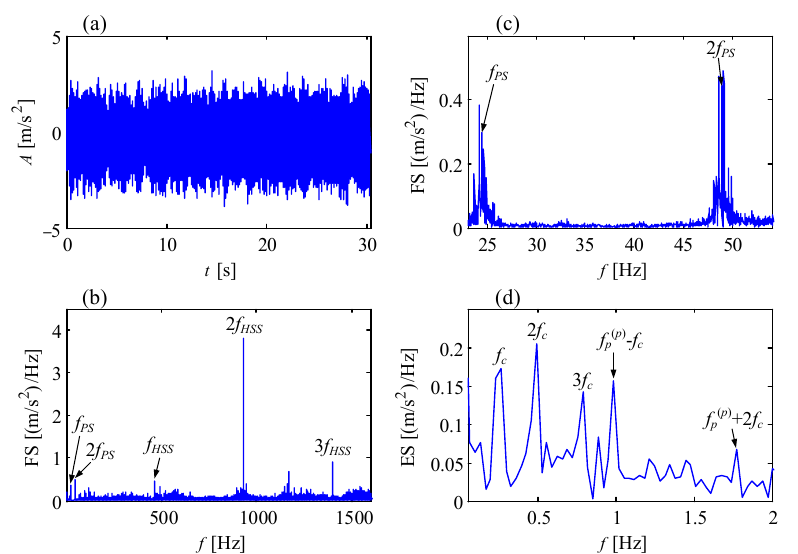
Figure 21. Vibration signal of chipped teeth of planet gear: ( a ) temporal signal; ( b ) Fourier spectrum; ( c ) Fourier spectrum near the mesh frequency of planetary stage; ( d ) envelope spectrum.